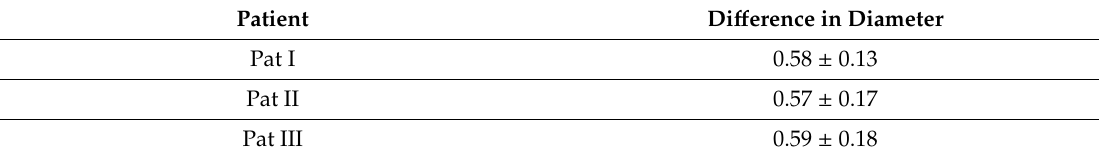
Table 6. Average di ff erence in diameter for hydraulic diameter included standard deviation ( ± SD).